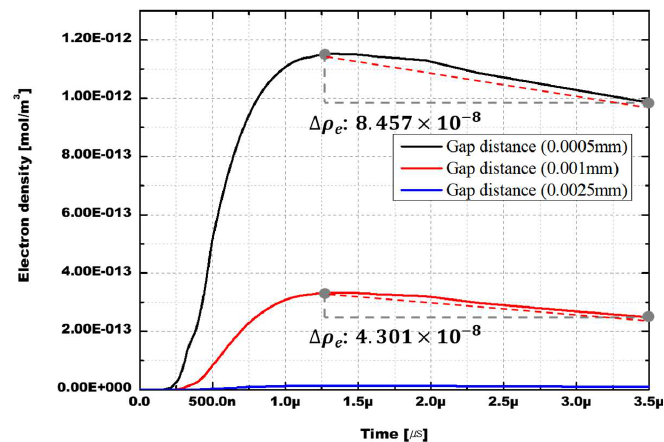
Figure 2. Electric field as a function of time at 0.5 kV (solid line: air space between ionizer conductor and current collector, dash line: tip part of SK-AOR380 lightning rod).